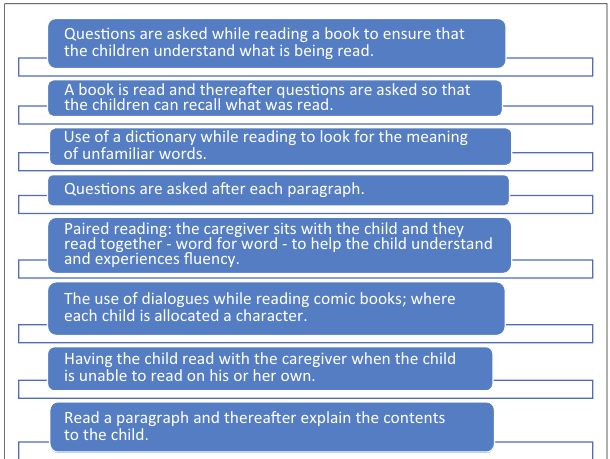
FIGURE 3: Caregivers’ awareness of the types of literacy